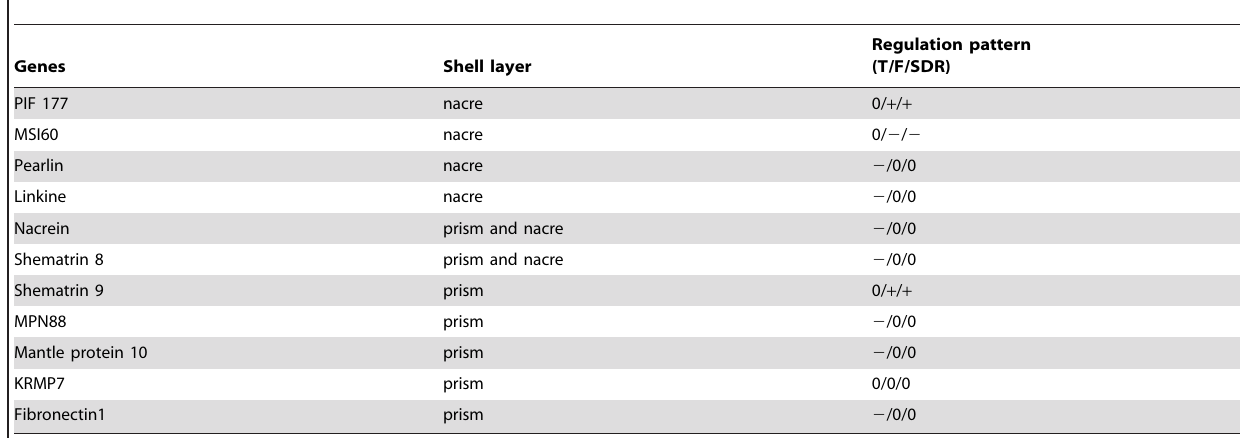
Table 4. Regulation pattern of genes according to temperature (T), food (F) and shell deposition rate (SDR).